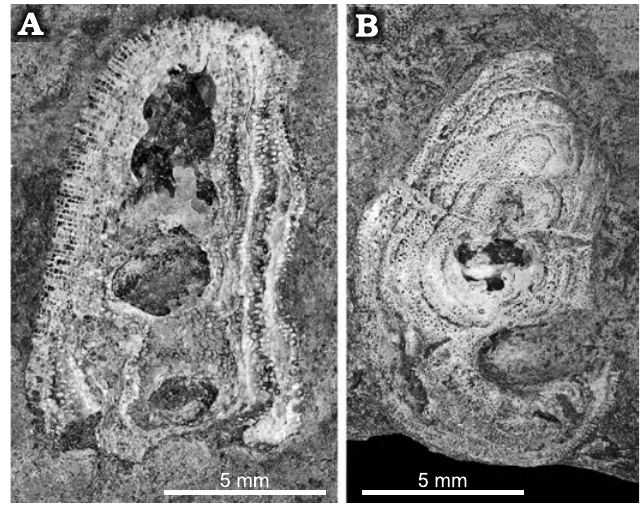
Fig. 2. Trepostome bryozoan Homotrypa cochlea sp. nov. from Upper Leintwardine Formation; Ludfordian, upper Ludlow, Silurian; Delbury Quarry, Shropshire, UK. A . NMW 2019.21G.7.1, bryozoan encrusting the surface of a gastropod shell. B . NMW 2019.21G.33, bryozoan encrusting the surface of a gastropod shell but not growing across